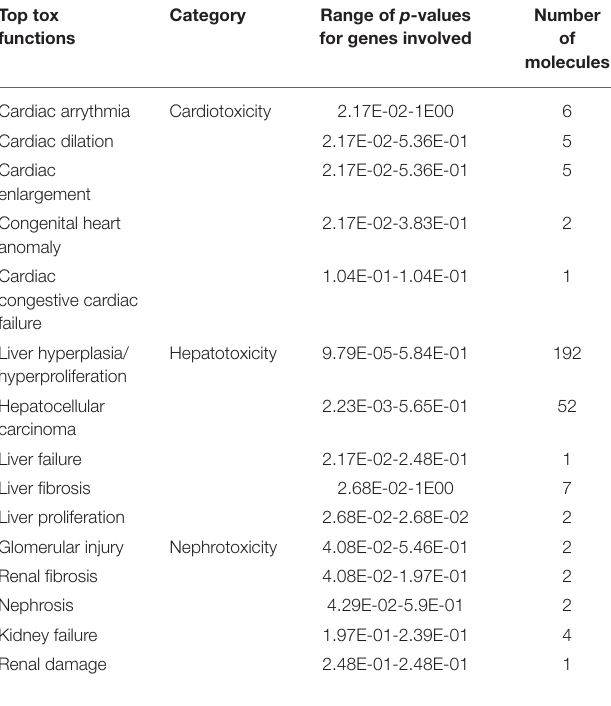
TABLE 5 | Top tox functions modified with Covid-19 exposure.